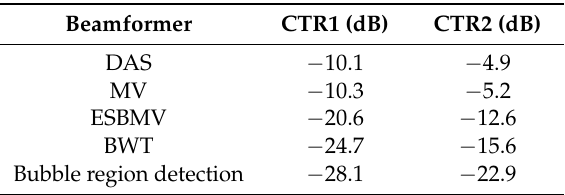
Table 3. The image CTR of different